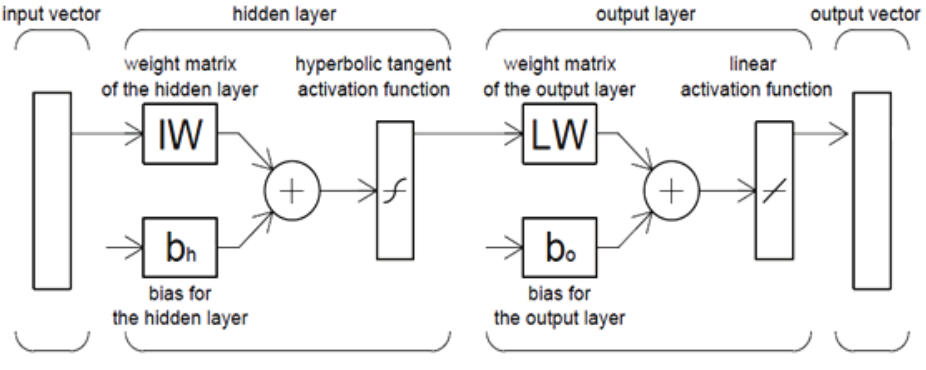
Fig. 1. The structure of MLP neural network used for prediction